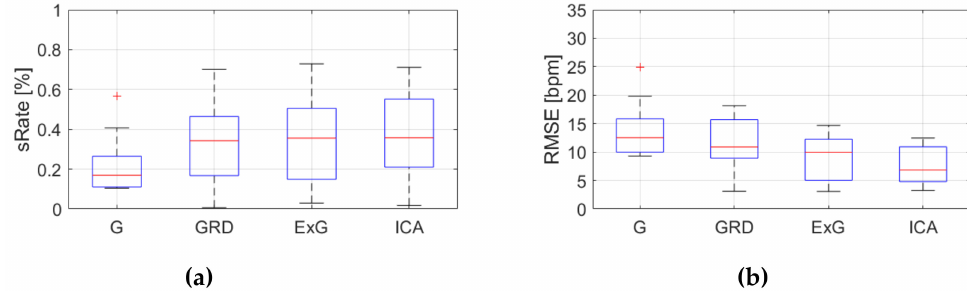
Figure 19. Comparison of signal extraction methods, algorithm No.3 (TIME), part 4: ( a ) box plots for sRate ; ( b ) box plots for RMSE . Blue lines—IQR range, red line—median value.